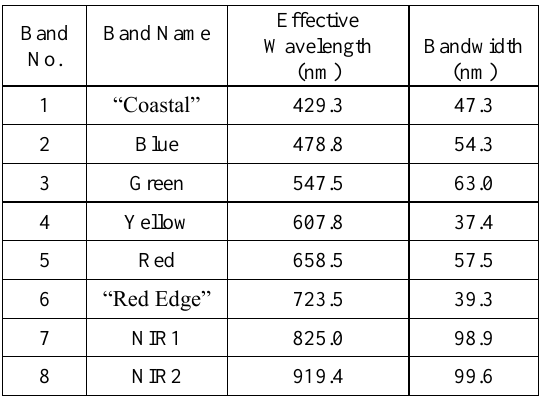
Table 1. Effective wavelengths and bandwidths of the WorldView-2 spectral